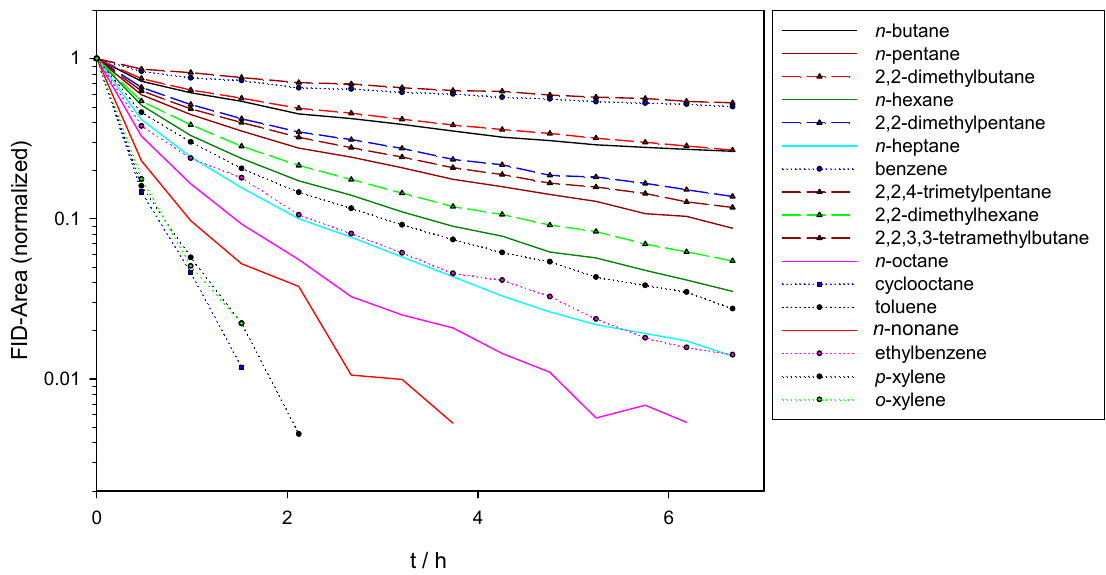
Figure 2. Decrease of hydrocarbon concentrations (normalized by n -perfluorohexane) during a smog chamber run by reaction with OH at 288 K (corresponding information at 248 K is displayed in the SI).